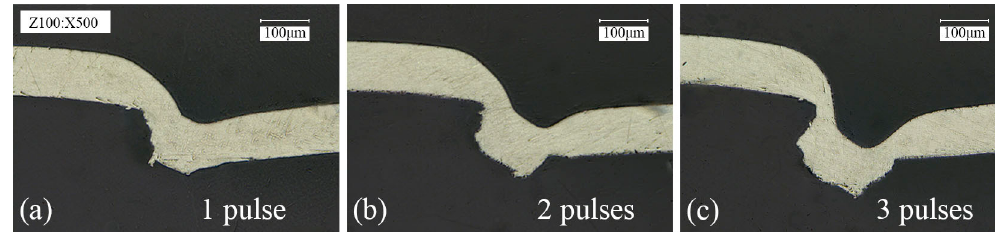
Figure 5. Cross sections of single layer 1060 pure aluminum foil (100 μ m in thickness) produced under different number of laser pulses ( h = 70 μ m, En = 1290 mJ): ( a ) 1 pulse; ( b ) 2 pulses; ( c ) 3 pulses.